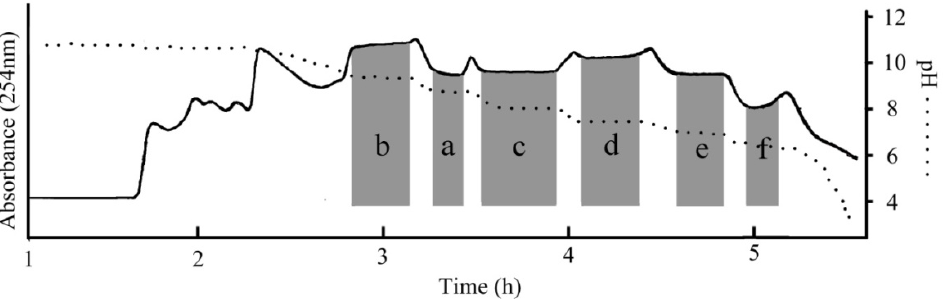
Figure 3. pH-zone-refining CCC chromatogram of preparative separation of alkaloids compounds from Picrasma quassioides ; Conditions: Two-phase solvent system: petroleum